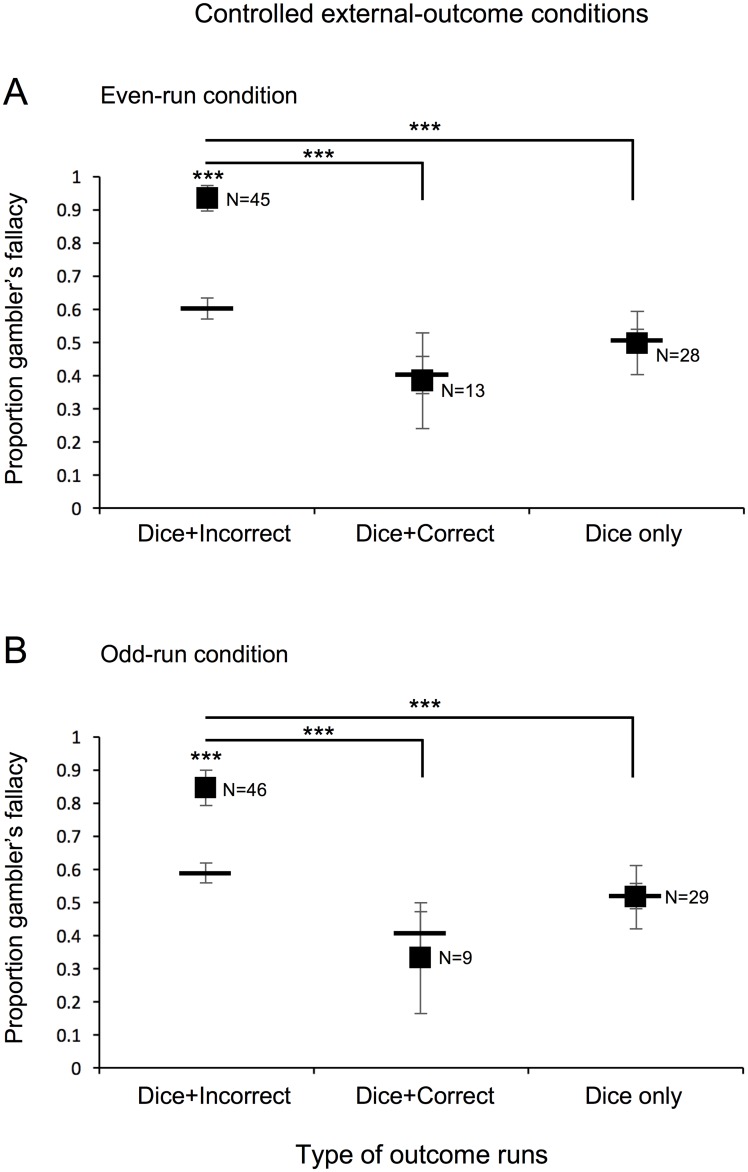
Experiment 3: Controlled external-outcome conditions.Proportion of participants predicting a changed-dice outcome (gambler’s fallacy) on the critical trial in the controlled external-outcome conditions following a run of (A) even or (B) odd dice outcomes. Participants were tested in either the even-run or odd-run condition whereas those in experiment 1 were tested in both conditions. Participants are grouped according to whether they concurrently had a run of incorrect predictions (Dice+Incorrect), a run of correct predictions (Dice+Correct), or no runs of prediction outcomes (Dice only). Horizontal bars indicate the average baseline probability of predicting a changed-dice outcome for each group. Error bars represent ±1 standard error of the mean. * p < 0.05, ** p < 0.01, and *** p < 0.001 reflect Wilcoxon signed-rank test against baseline within each group or pairwise Chi-squared comparisons across groups.